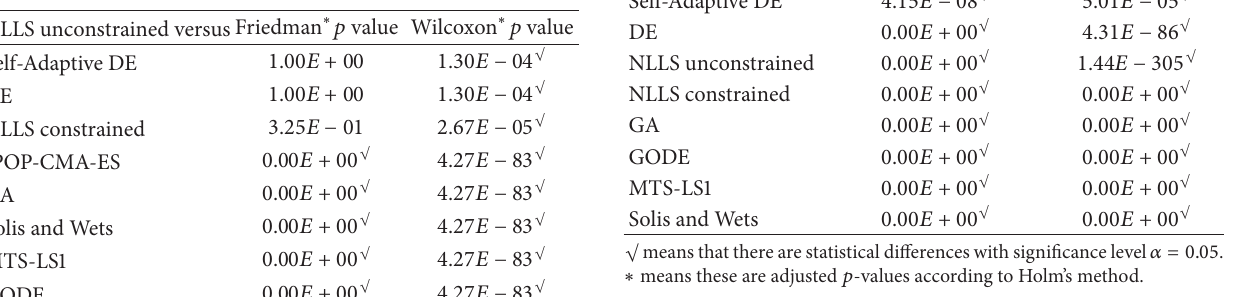
Table 19: Corrected 𝑝 values according to Holm’s method (NLLS unconstrained is the control algorithm) for the 9th degree polyno- mial.